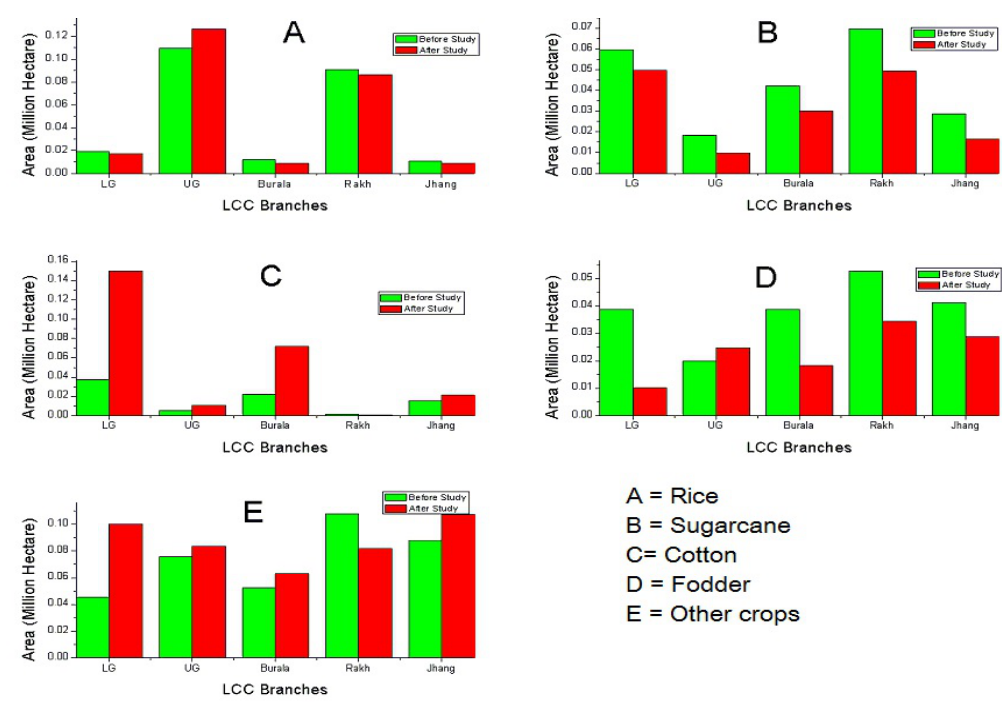
Figure 6. Kharif crops acreage on branches of LCC.